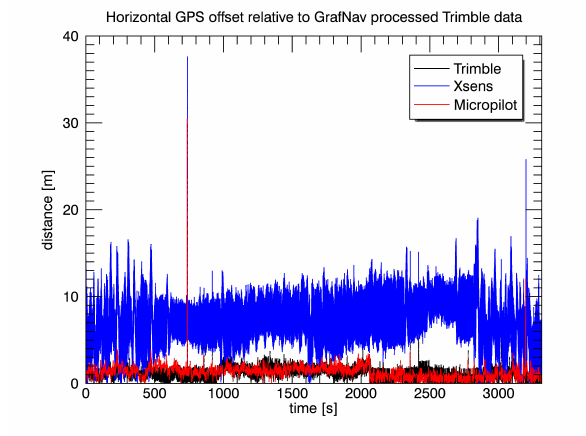
Figure 2: Horizontal accuracy of different GPS receivers, com- pared to GrafNav post processed Trimble data. The time axis is in seconds from launch.